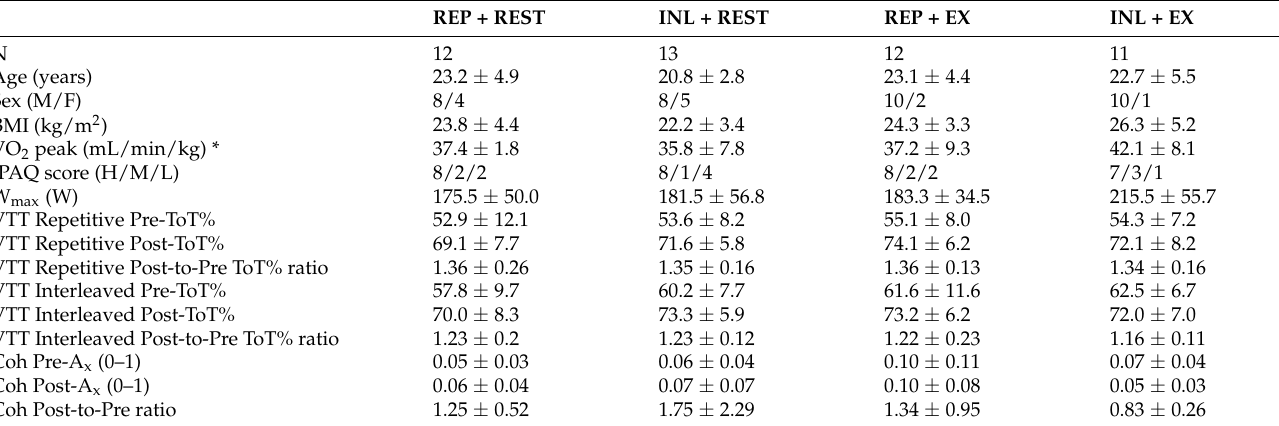
Table 1. Participant